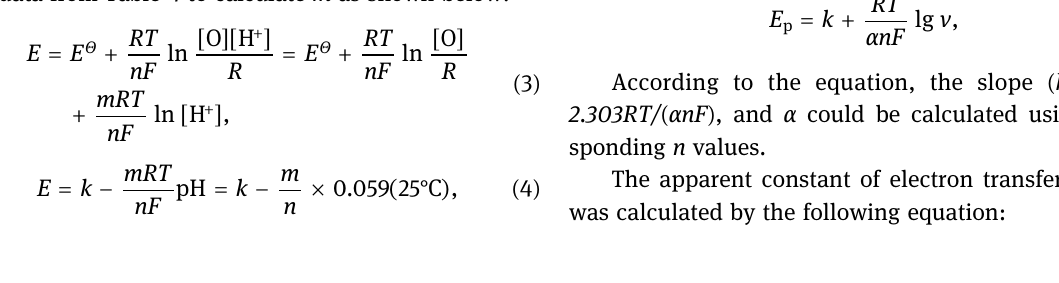
Table 5: Linear relationship of four polyphenolic compounds between oxidation peak current and scan rate Matter Range of scan rate ( V/s ) Linear regression equation r Control process